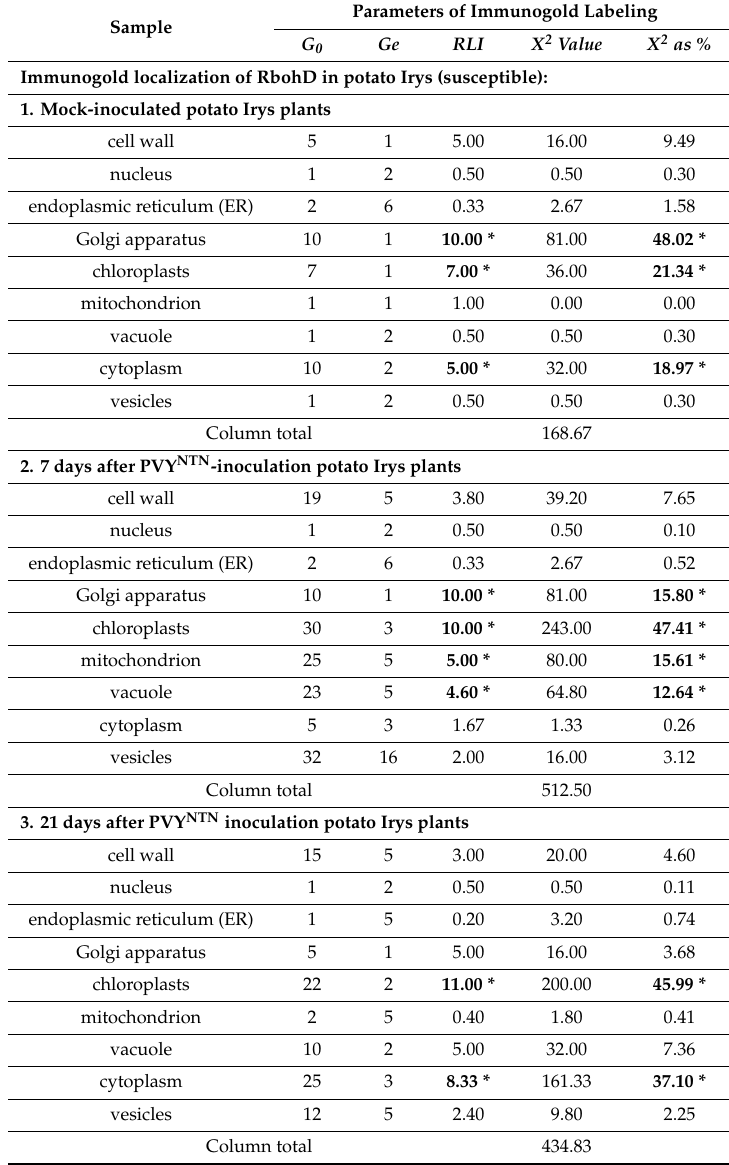
Table 3. Quantification of immunogold labeling of RbohD by RLI and X 2 tests in mock-inoculated and PVY NTN -inoculated Irys before systemic symptoms (7 dai) and after (21 dai) systemic necrosis developed. Significant values (RLI > 1, and % X 2 at least 10%) are in bold font and marked with an